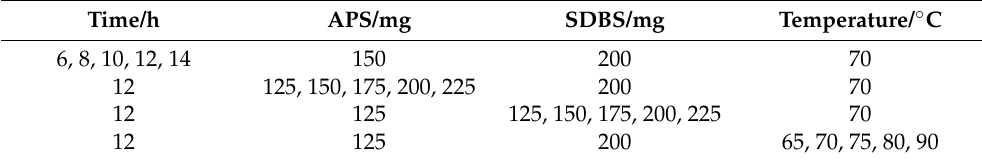
Table 1. Single-factor variables of emulsion polymerization of P(St-AA) colloidal microspheres. Time/h APS/mg SDBS/mg